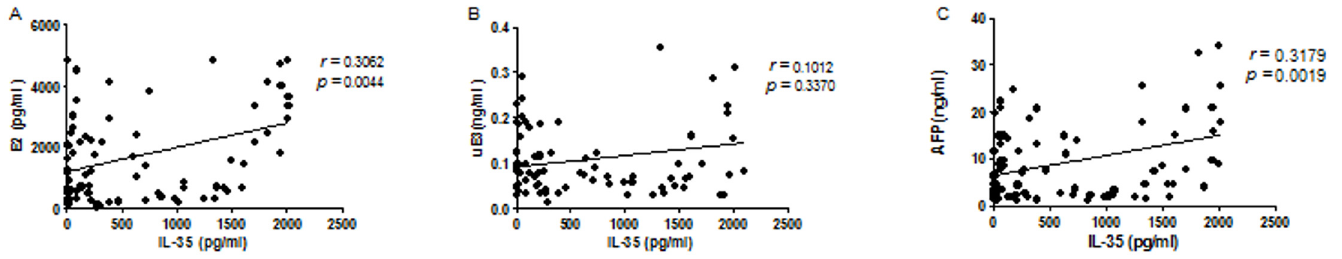
Fig 4. The correlation of estrogen and AFP levels with IL-35 in early pregnancy. P < 0.01 represents a significant correlation using the Spearman